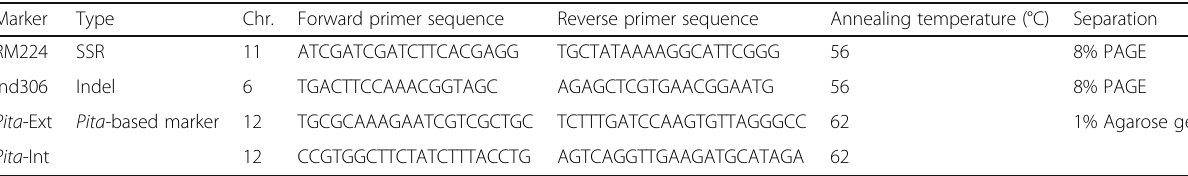
Table 1 Molecular markers used for foreground selection in this study Marker